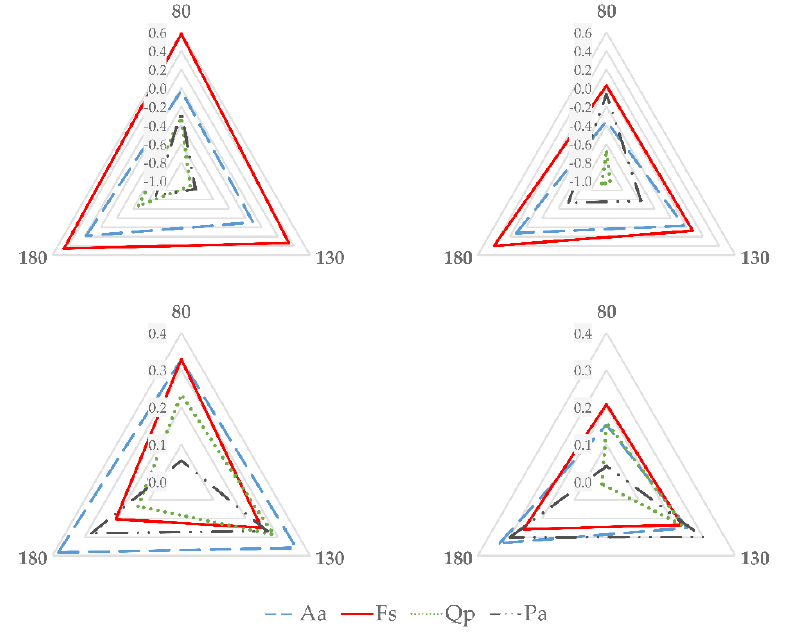
Figure 7. Tree species average error (cm) comparison of (first row) estimated perimeter and (second row) diameter using (first column) non-fisheye and (second column fisheye lens) (Aa: Abies alba Mill.; Fs: Fagus sylvatica L.; Qp: Quercus petraea (Matt.) Liebl.; Pa: Picea abies (L.) H. Karst.).